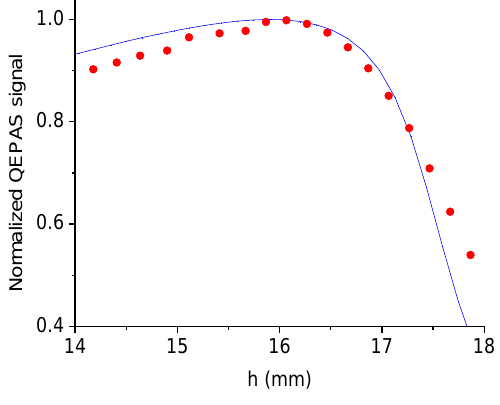
Figure 16. Normalized experimental results (dots) of the QEPAS signals as a function of the vertical position of T-QTF. Data are obtained by detecting 1.55% of methanol in N 10 Torr and by using the experimental setup depicted in Figure 17. The solid line is the related best fit curve using Equation